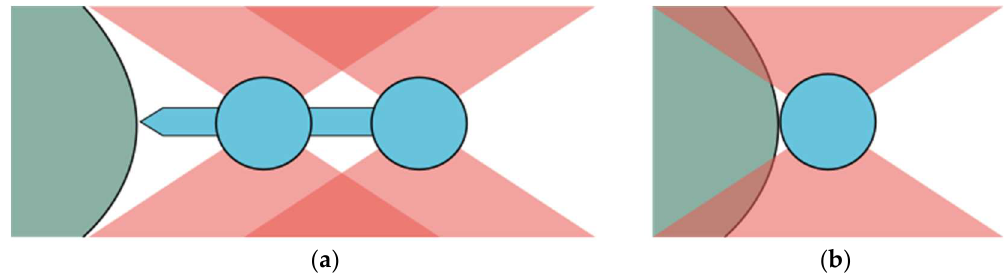
Figure 1. ( a ) For probing with a micro-dumbbell, the examined object (green) is not exposed to the focused trapping beams, whereas for a single bead ( b ) a fraction of the beam illuminates the object and may cause unwanted effects.